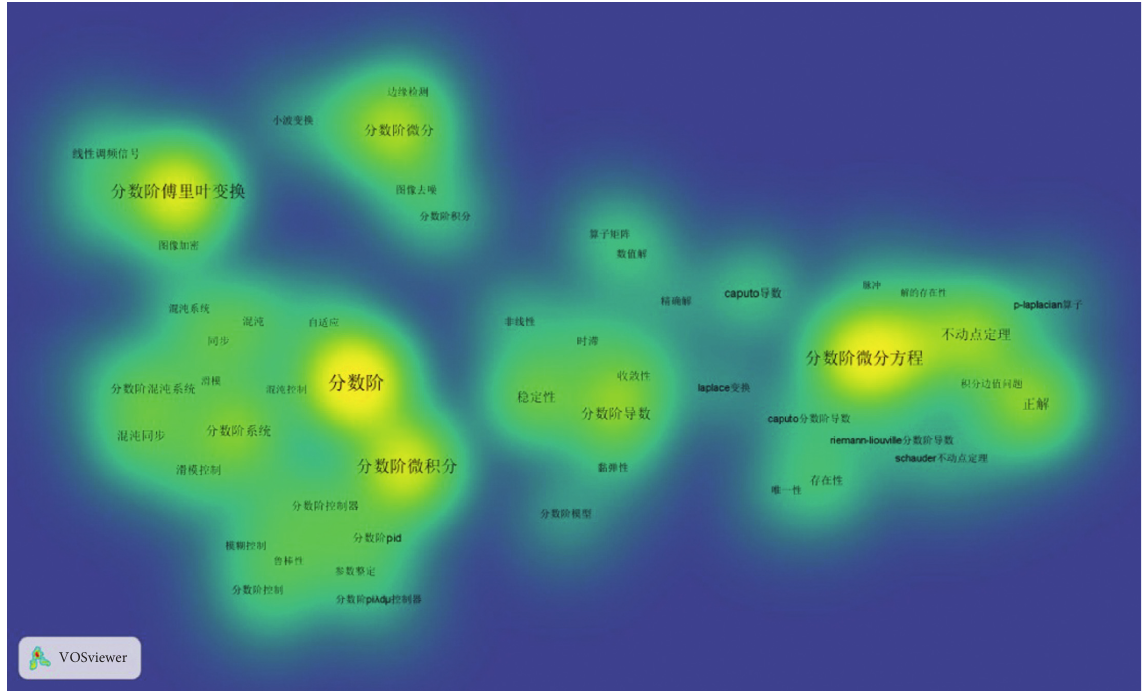
Figure 5: Visualization map of keyword density. Note: the keywords translation in Figure 5 is shown in Table 3. Table 4: Occurrence distribution of the top 20 keywords.